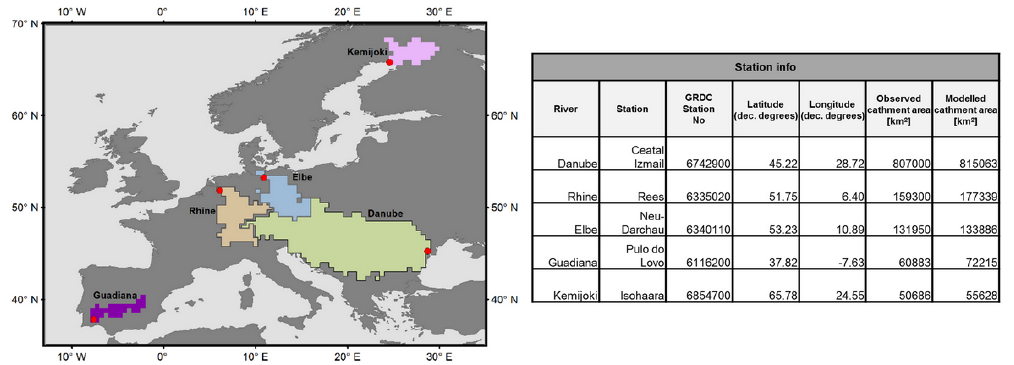
Figure 1. European study domain, tested basins as defined by the model’s 0.5 ◦ resolution, gauging stations and general information on the